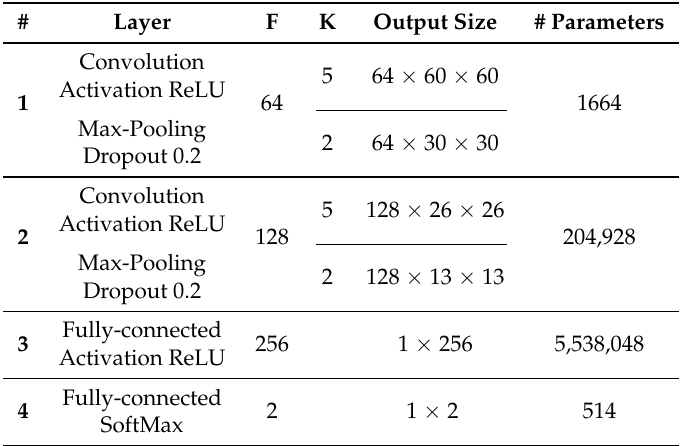
Table 1. Description of the baseline